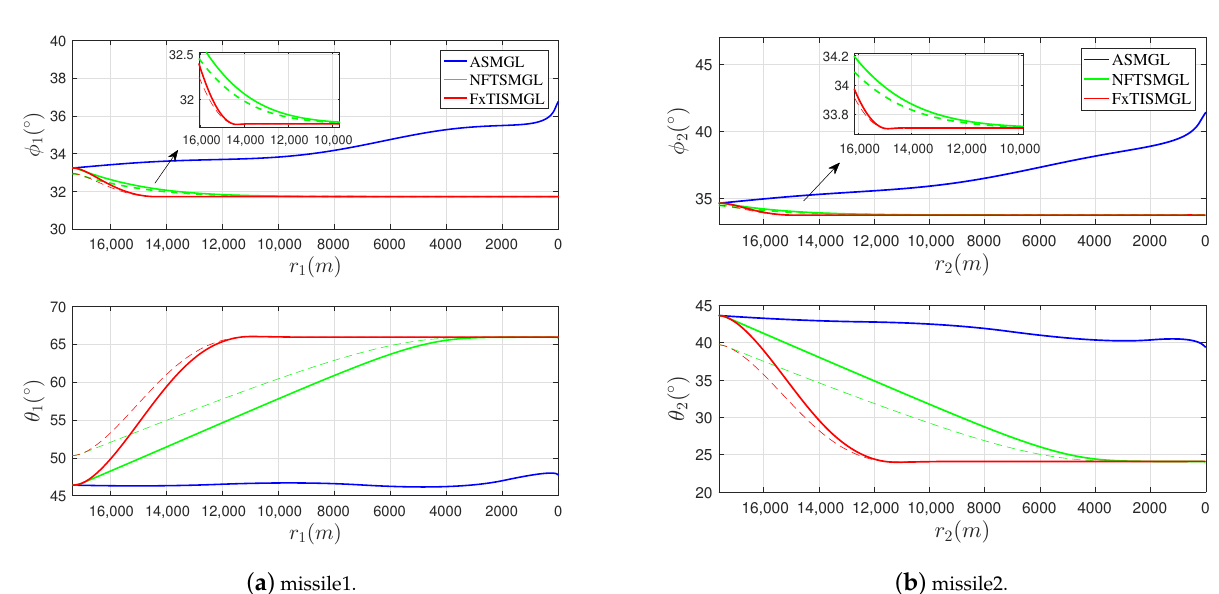
Figure 6. The curves of the LOS angles. Solid line: actual value, dashed line: commanded value.